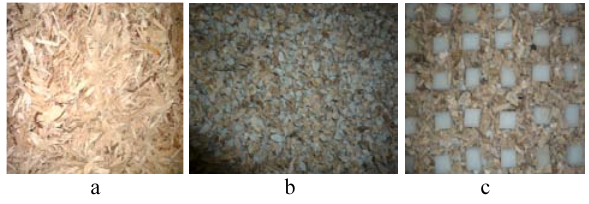
Fig. 2. Biofilter charges: a – wood chips; b – mixture of natural zeolite and wood chips; c –mixture of foam cubes and wood